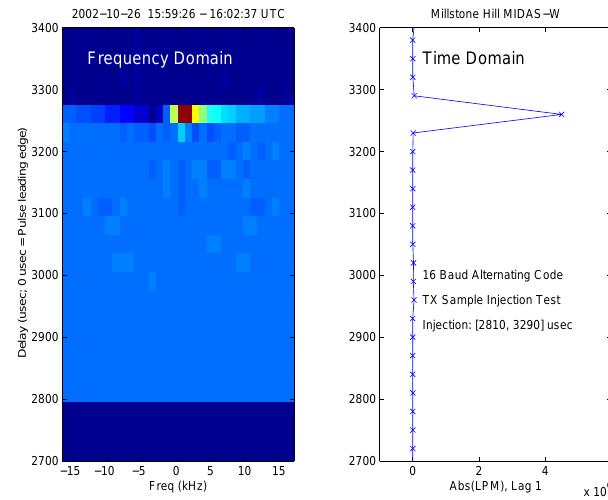
Fig. 8. An example of range dependent incoherent scatter correla- tion functions and spectral returns derived from a lag profile matrix using the Millstone Hill Software Radar implementation.